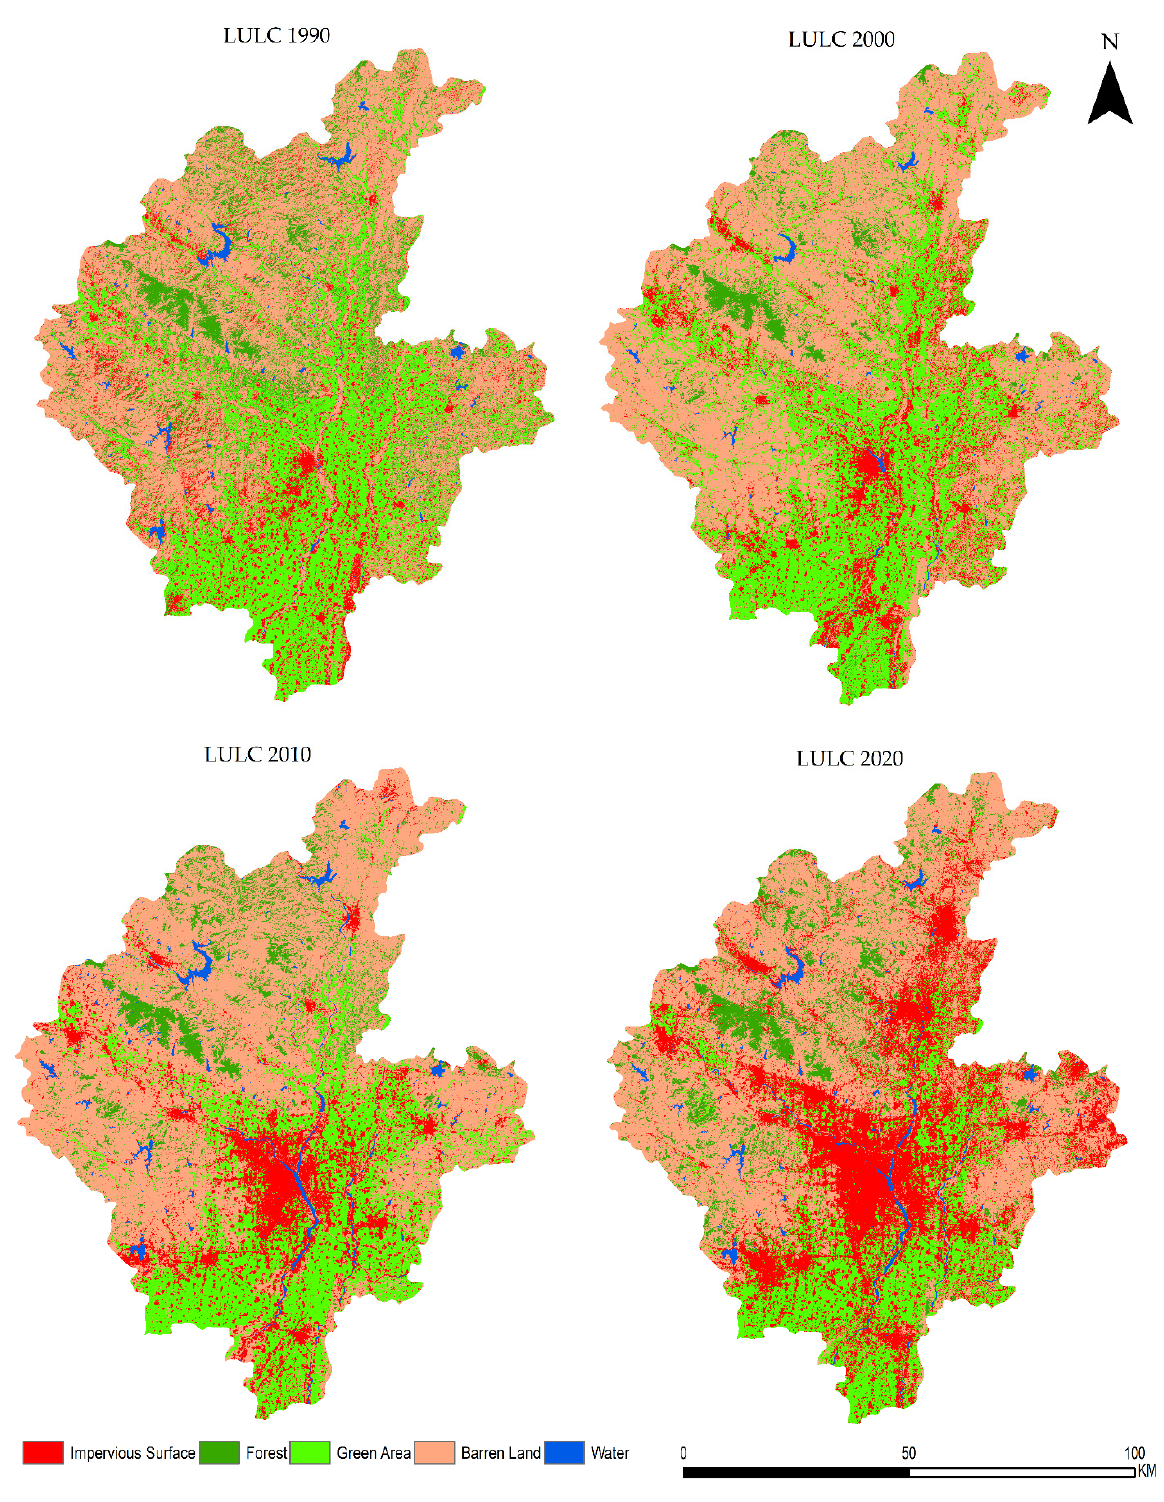
Figure 3. Linyi LULC maps.